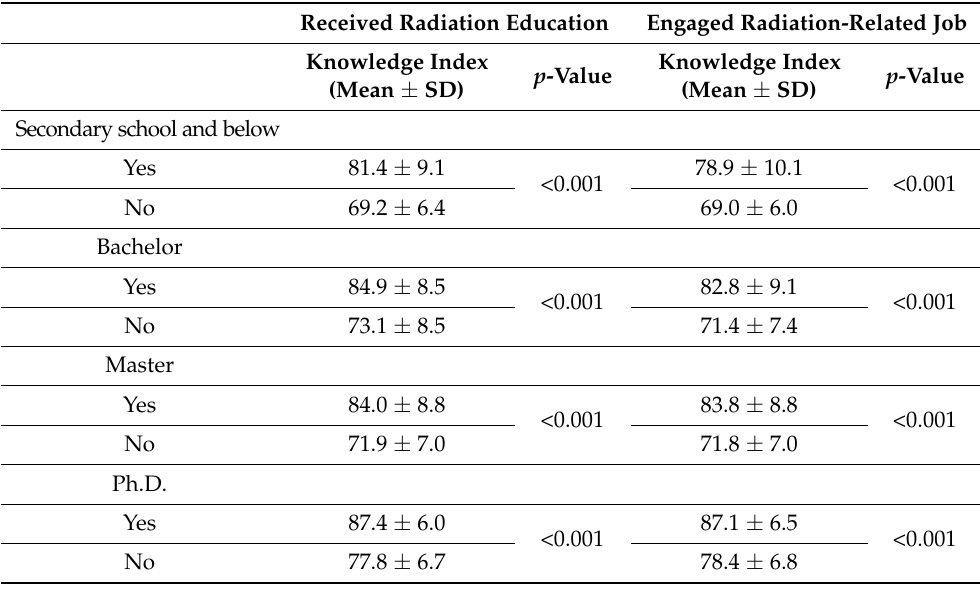
Table 4. The t -test results of received radiation education and engaged radiation-elated job within each education